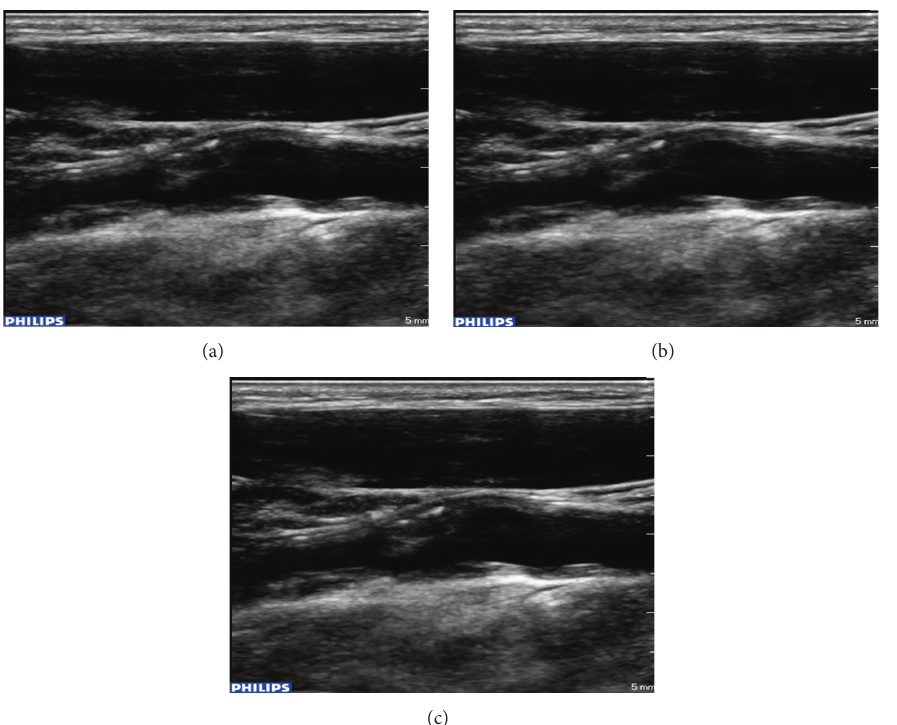
Figure 5: Video image examples of a typical ultrasound video at the acquired, 560 × 416 video resolution. (a) Original ultrasound video, (b) scenario 1 (WLAN): 560 × 416 @ 768 kbps, PSNR: 39.9 dB, and (c) scenario 2 (HSPA): 560 × 416 @ 768kbps, PSNR-VFD: 39.8